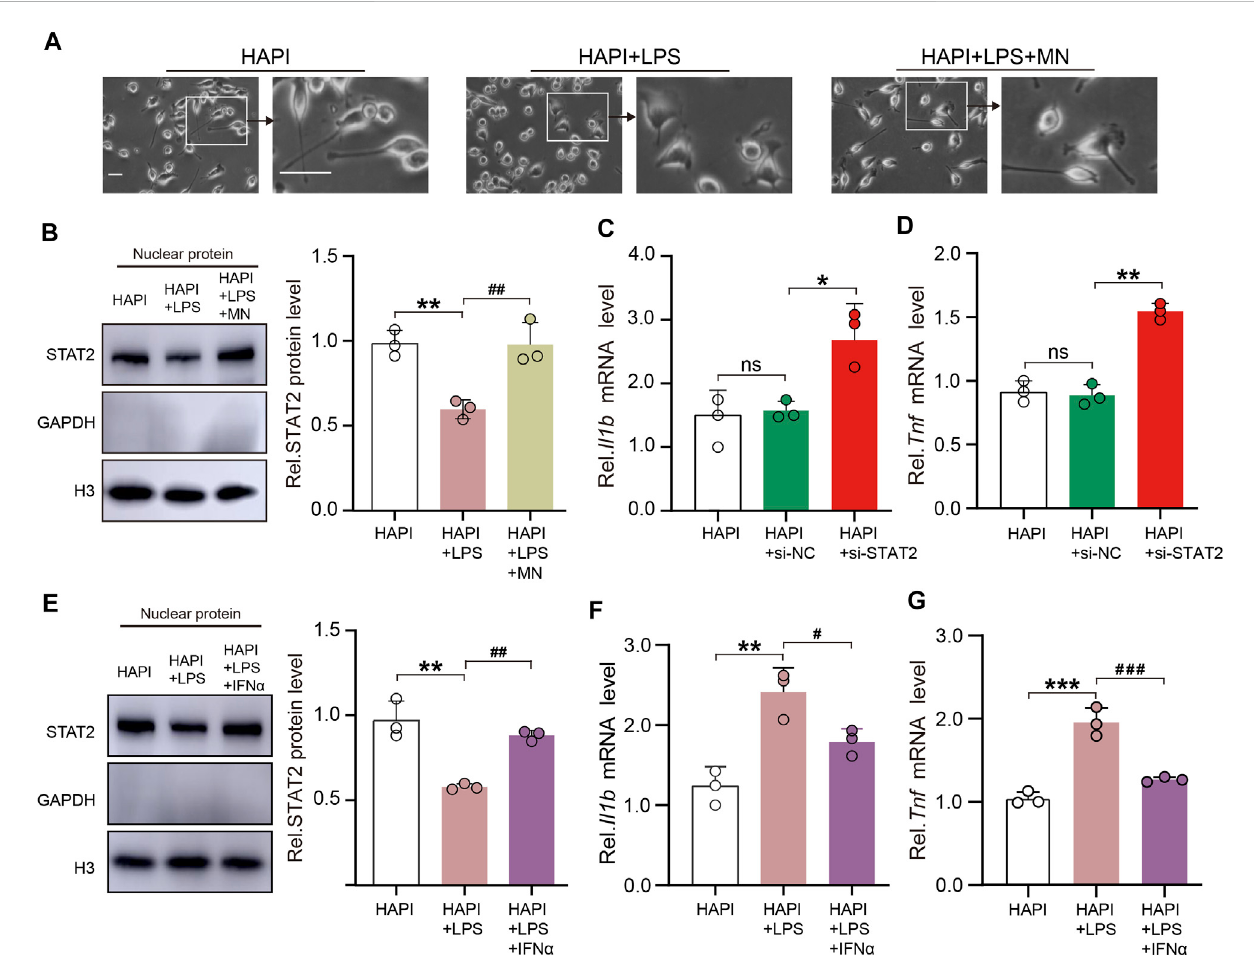
FIGURE 7 STAT2 in the nuclei negatively regulates pro-in fl ammatory gene expression in microglia. (A) Representative images of HAPI microglia showed that lipopolysaccharides (LPS) activated microglia and minocycline (MN) signi fi cantly inhibited microglia activation (Activated microglia had enlarged cytosomes, shortened protrusions, and amoeba-likecell morphology, scale bar = 50 µm). (B) Nuclear expressionof STAT2 was reduced in activated HAPI microglia but it returned to basal level after the treatment of MN (HAPI vs. HAPI + LPS, ** p < .01; HAPI + LPS vs. HAPI + LPS + MN, ## p < .01, n = 3, one-way ANOVA followed by Bonferroni ’ s multiple comparisons test). (C,D) Expression of Il1b and Tnf mRNA was signi fi cantly increased in HAPI microglia after transfection of si-STAT2 ( n = 3, * p < .05, ** p < .01, one-way ANOVA followed by Bonferroni ’ s multiple comparisons test). (E) Nuclear expression of STAT2 was restored after treatment of IFN α (HAPI vs. HAPI + LPS, ** p < .01; HAPI + LPS vs. HAPI + LPS + IFN α , ## p < .01; n = 3, one-way ANOVA followed by Bonferroni ’ s multiple comparisons test). (F,G) Treatment of IFN α reversed the LPS-induced upregulation of Il1b and Tnf mRNA expression in HAPI microglia (HAPI vs. HAPI +